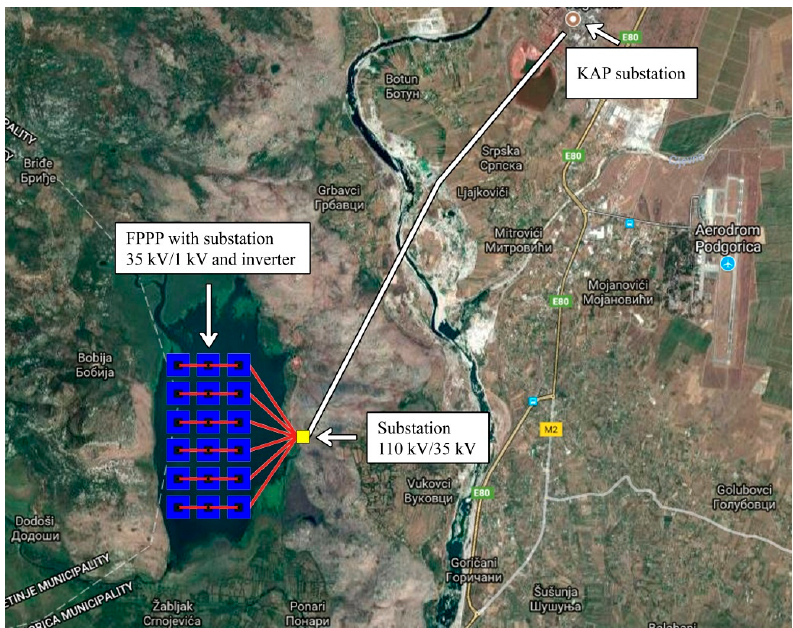
Figure 3. The configuration of the FPPP.